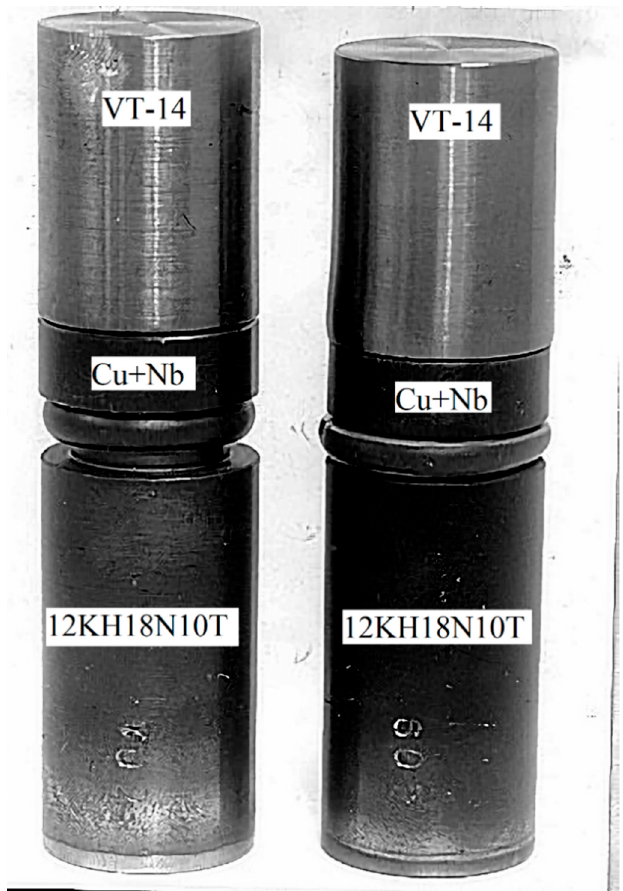
Figure 2. The 12KH18N10T+Cu+Nb+VT-14 sample before welding.